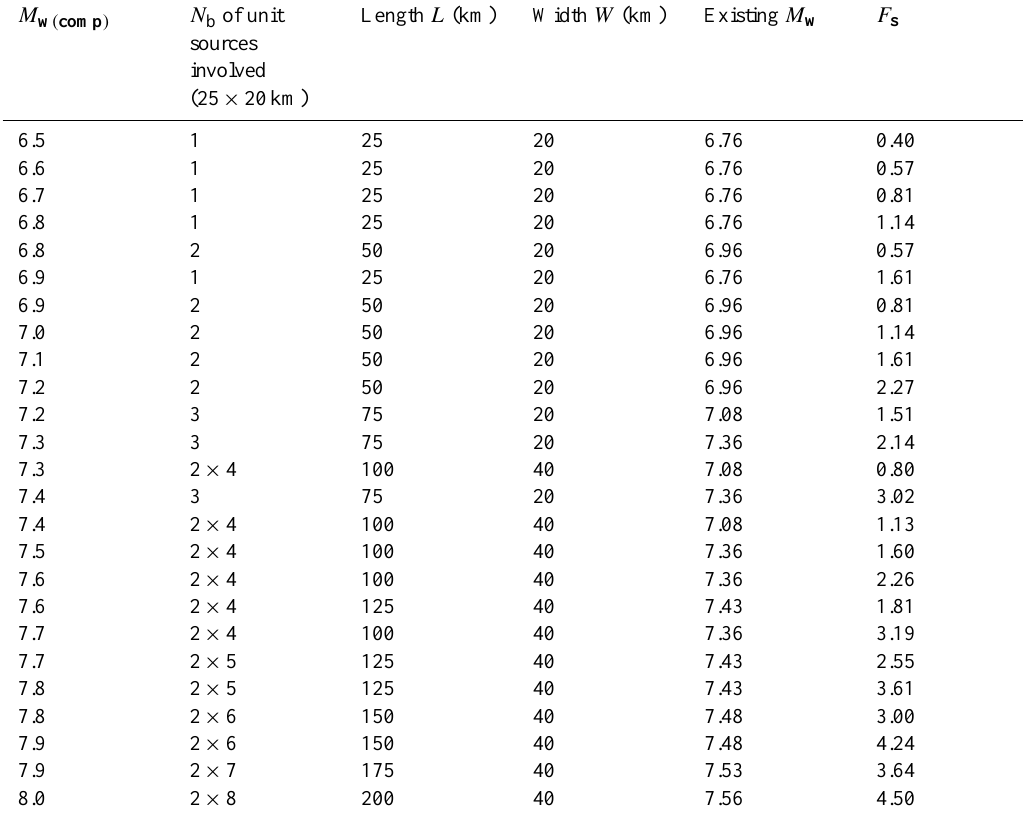
Table 1. Scaling factors ( F s ) required to produce a composite scenario of magnitude M w(comp) from the existing 25 × 20km 2 unit source functions in the western Mediterranean